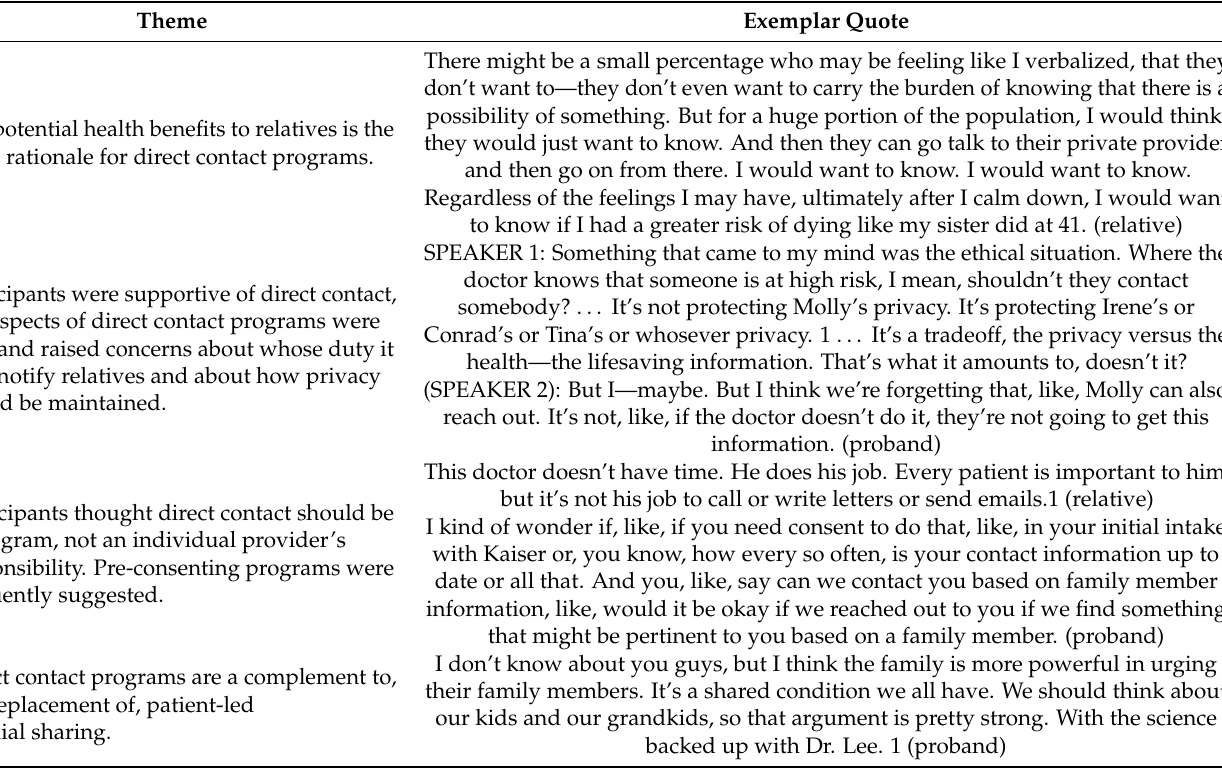
Table 2. Themes: patient and family preferences for direct contact